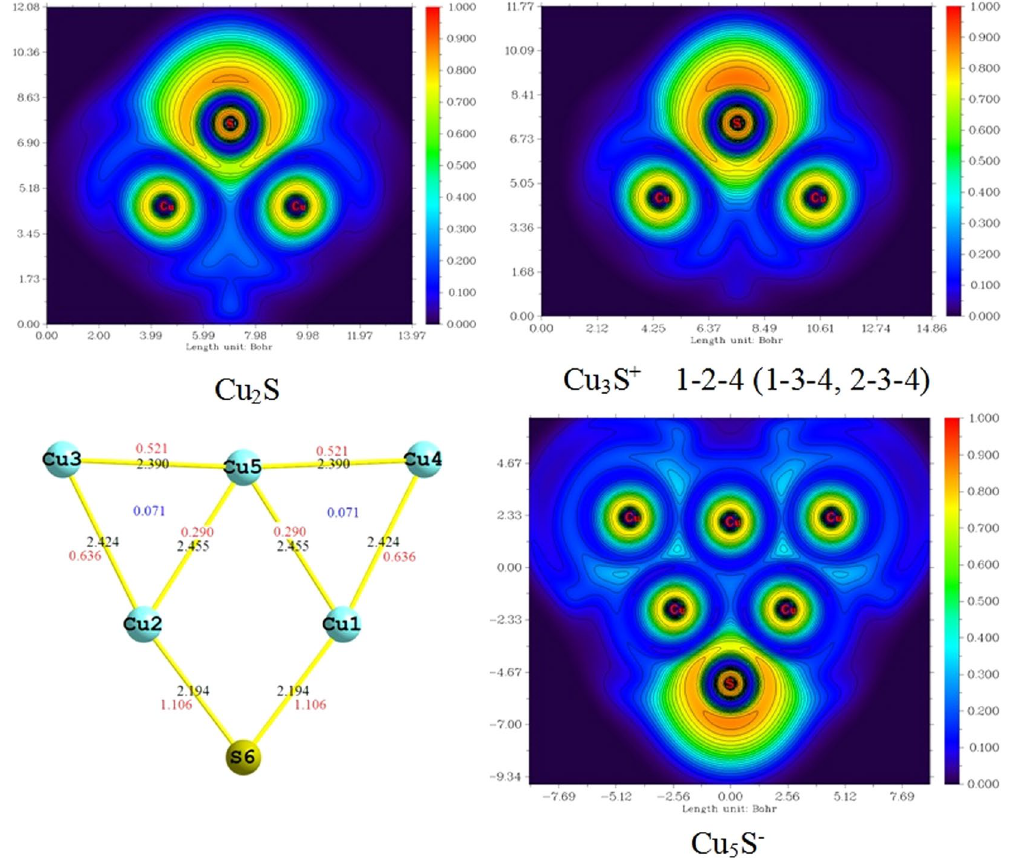
Figure 6. Geometrical parameters (bond length, in Å) of Cu 2 S, Cu 3 S + and Cu 5 S − clusters and their ELF cut planes and Mayer Bond